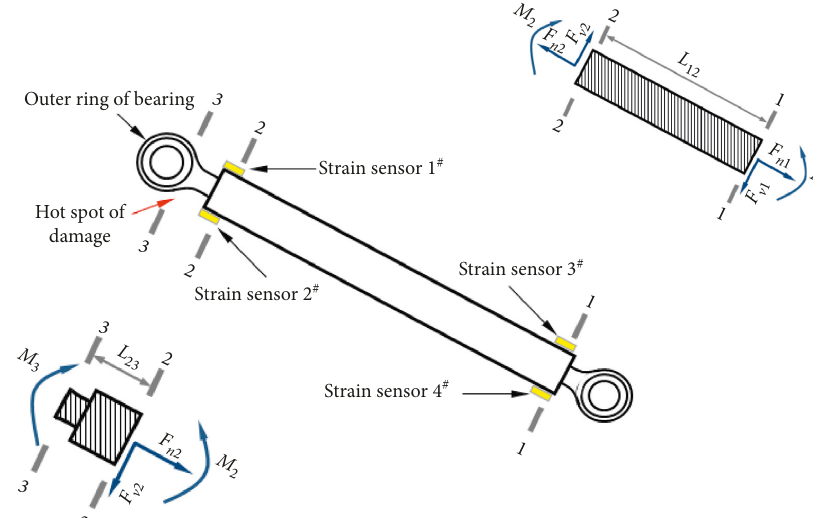
Figure 8: Applied force analysis of pull